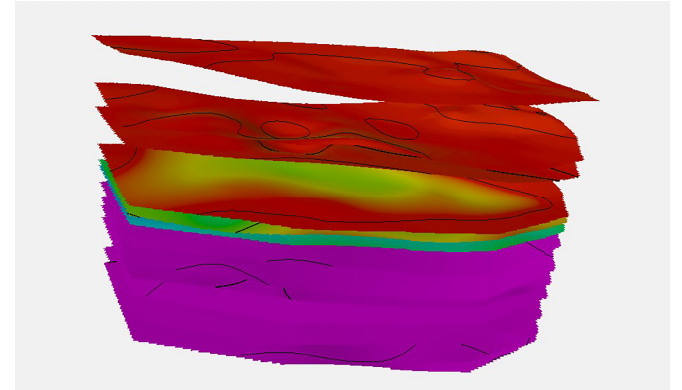
Figure 3. Scope of work area.